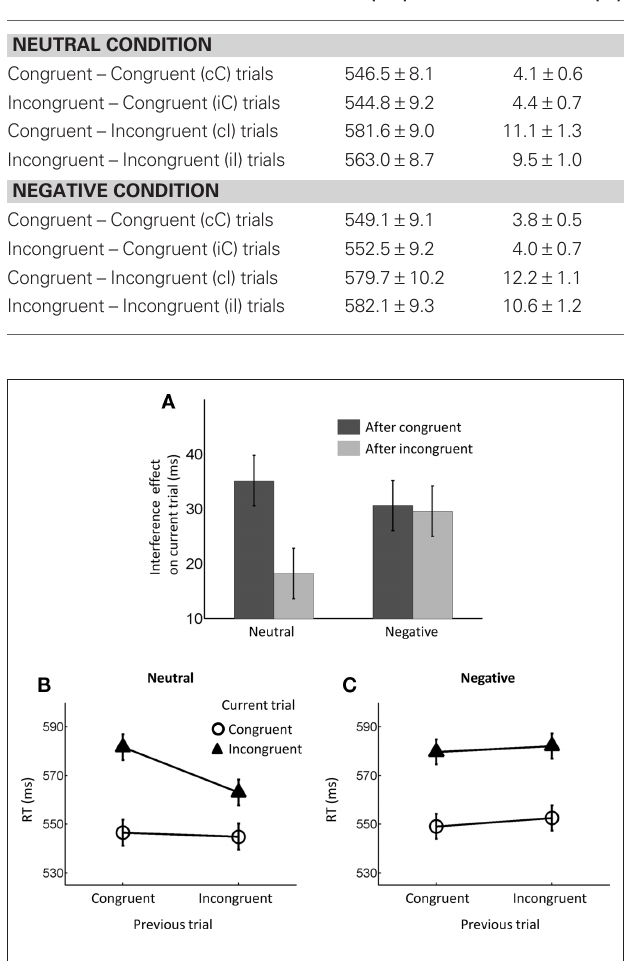
Figure 2 | reaction time (rT) conflict adaptation effects. (a) Bar plot of interference (incongruent–congruent) RT effects based on previous-trial congruency displayed for both neutral and negative conditions. Error bars represent standard within-subject standard error bars (Loftus and Masson, 1994) for the three-way interaction. (B) Mean RT data displayed as a function of previous- and current-trial congruency during trials preceded by neutral emotion and (c) negative emotion. Error bars in (B,c) represent standard within-subject standard error bars (Loftus and Masson, 1994) for